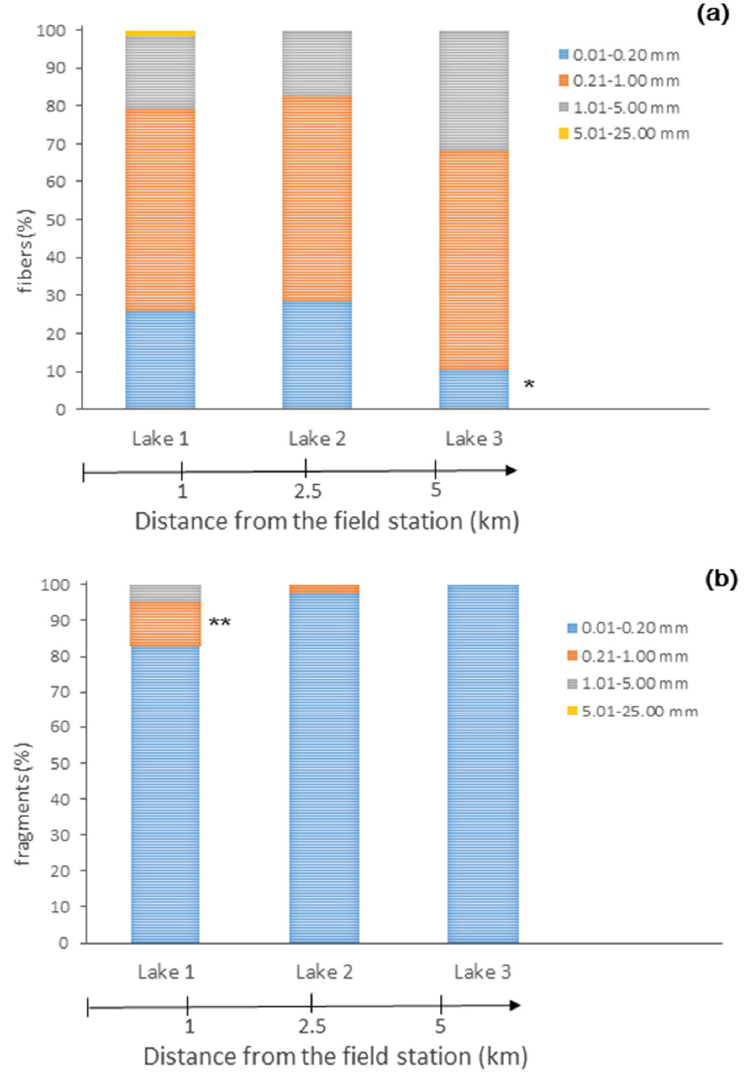
Figure 5. The percentage of microplastic ( a ) fibers, ( b ) fragments of different size classes (0.01–0.20 mm, 0.21–1.00 mm, 1.01–5.00 mm), and mesoplastic (5.01–25 mm) from the surface water of the studied tundra lakes. The distance (in km) from the field station is shown by the arrows at the bottom of the graphs. Statistically significant differences are indicated by * p < 0.05 and ** p < 0.005. As for MP fragments, similar to the situation in the bays, the small ones were dominant (93 ± 10% of all fragments detected were in the range of 0.01–0.20 mm; Figure 5b), and large fragments were not detected. There were significant differences in the proportions of medium (0.21–1.00 mm) fragments across the lakes (ANOVA, F 2,6 = 17.6, p = 0.003). The highest percentage of medium fibers was found in Lake 1, as compared to Lake 2 and 3 (Tukey’s test, p = 0.01 and p = 0.003, respectively; Figure 5b). Lake 1 was the only lake in which large fragments were detected. The results for Lake 3, which is farthest from the field station, indicated the presence of only small fragments (Figure